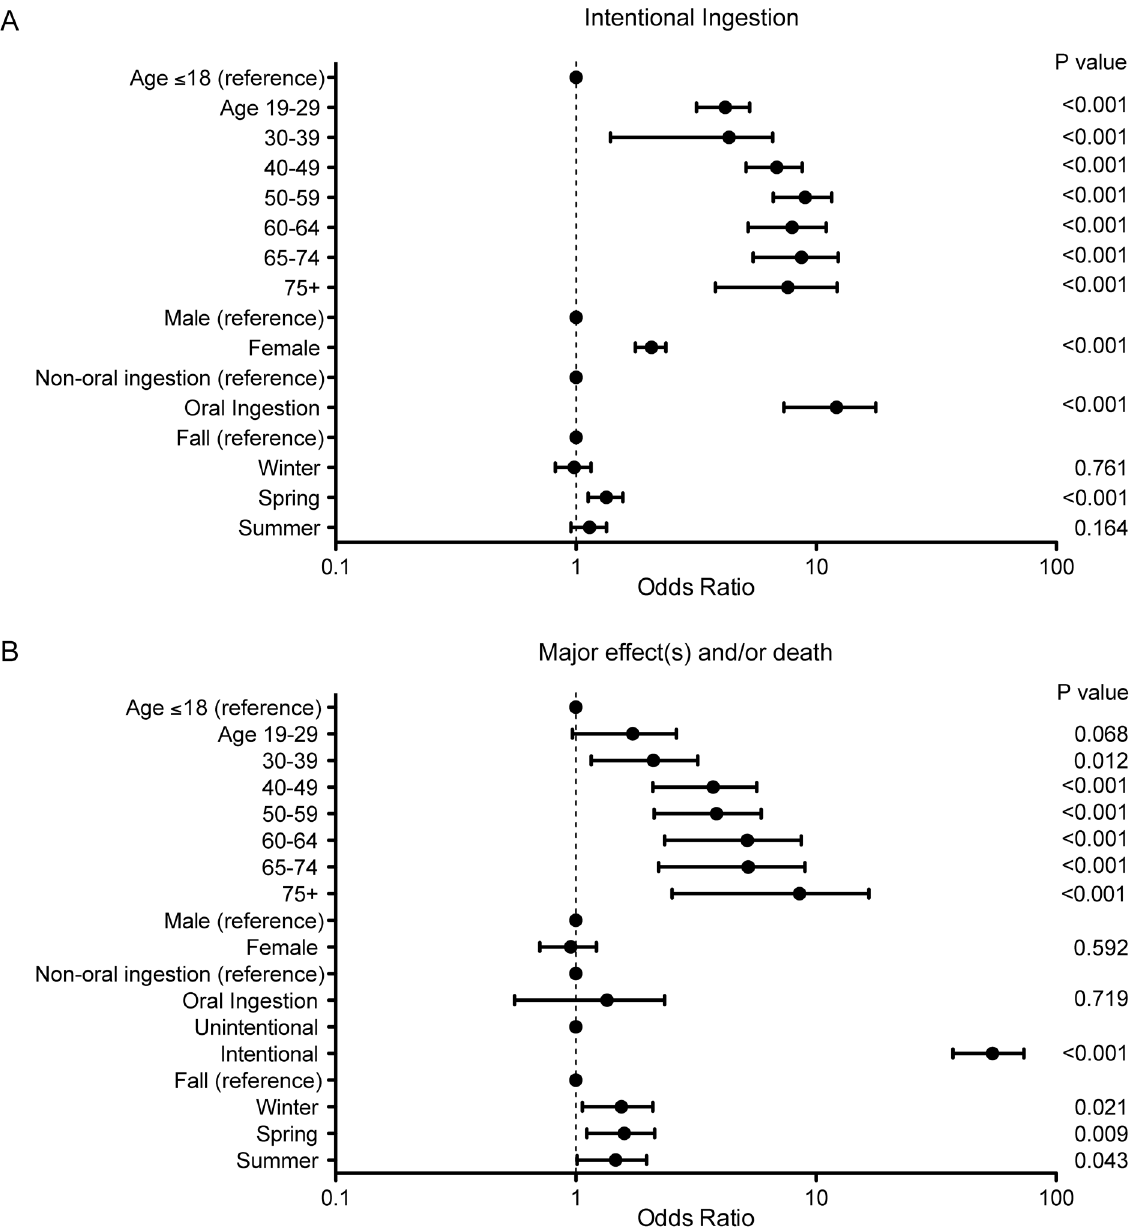
Fig 1. Logistic regression analysis of risk factors associated with ethylene glycol ingestion. Age is reported in years and each group is compared to age (cid:1) 18 years. Oral ingestion is compared to all known types of other exposures (unknowns excluded). Listed seasons are compared to Fall. Bonferroni- corrected p -value < 0.003 (0.05/17 or 18 comparison variables) is considered significant. (A) Multivariate model of variables associated with intentional ingestion (C-statistic = 0.74). (B) Multivariate model of variables associated with major effect(s) and/or death (C-statistic = 0.92). See S4 Table for additional